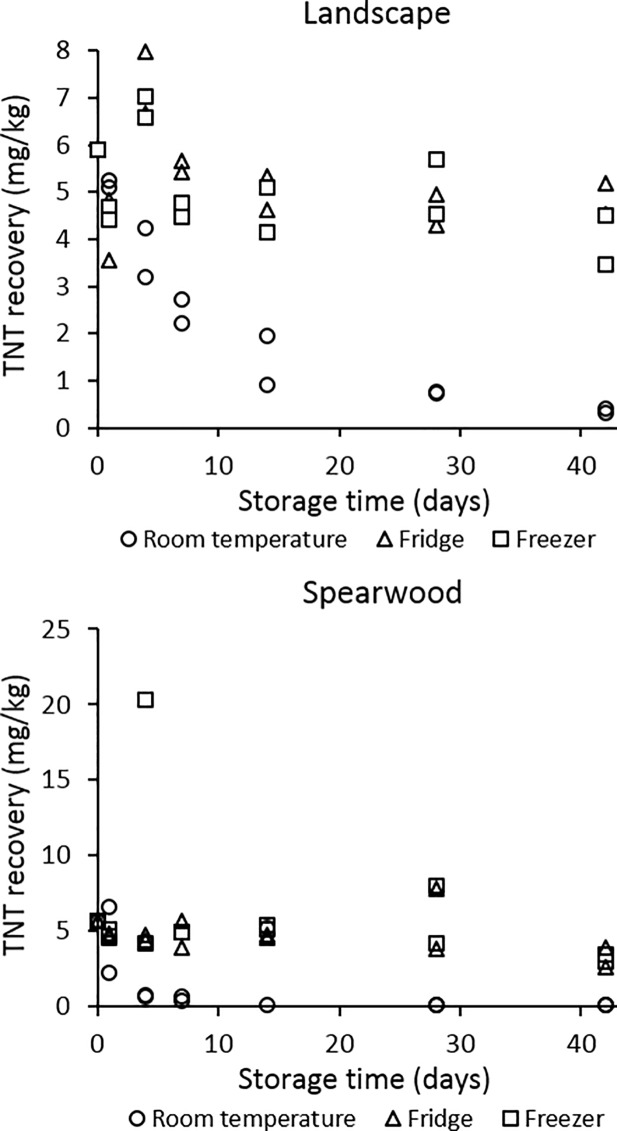
TNT recoveries obtained from post-blast landscape and Spearwood soil samples and stored at 3 temperatures, extracting over 6 weeks.